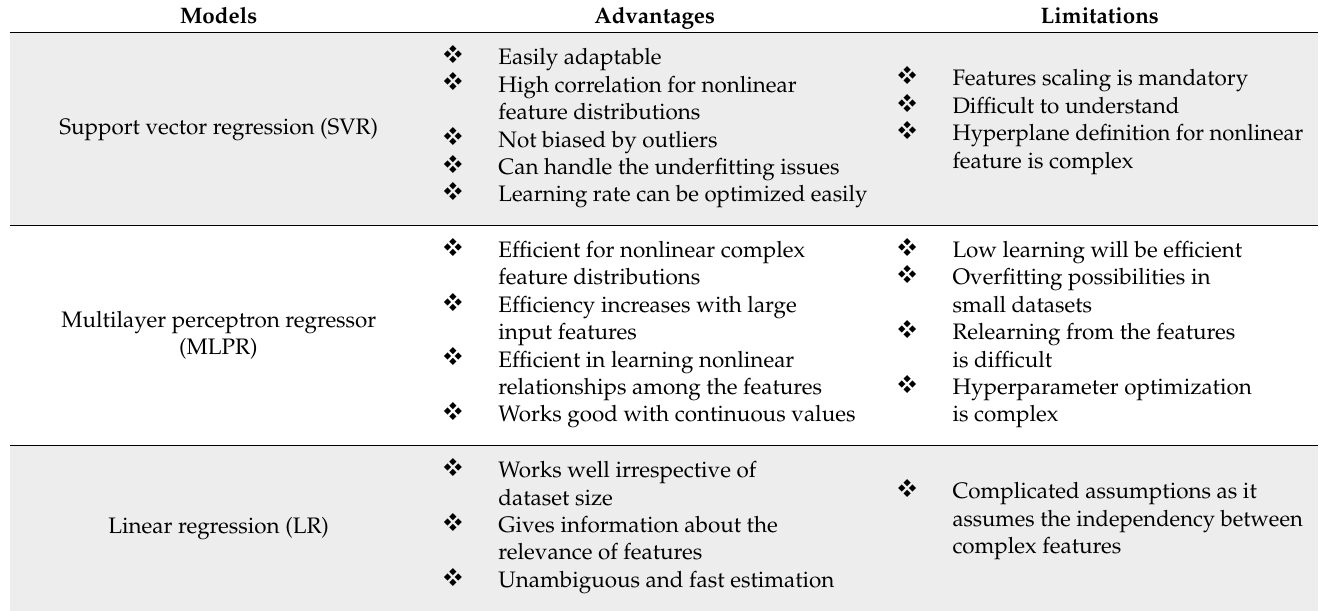
Table 3. Details of proposed models.